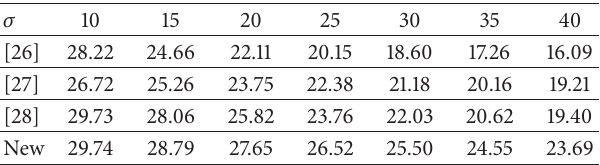
Table 3: PSNR of different algorithms with different Speckle noise levels for Miss America video sequence.